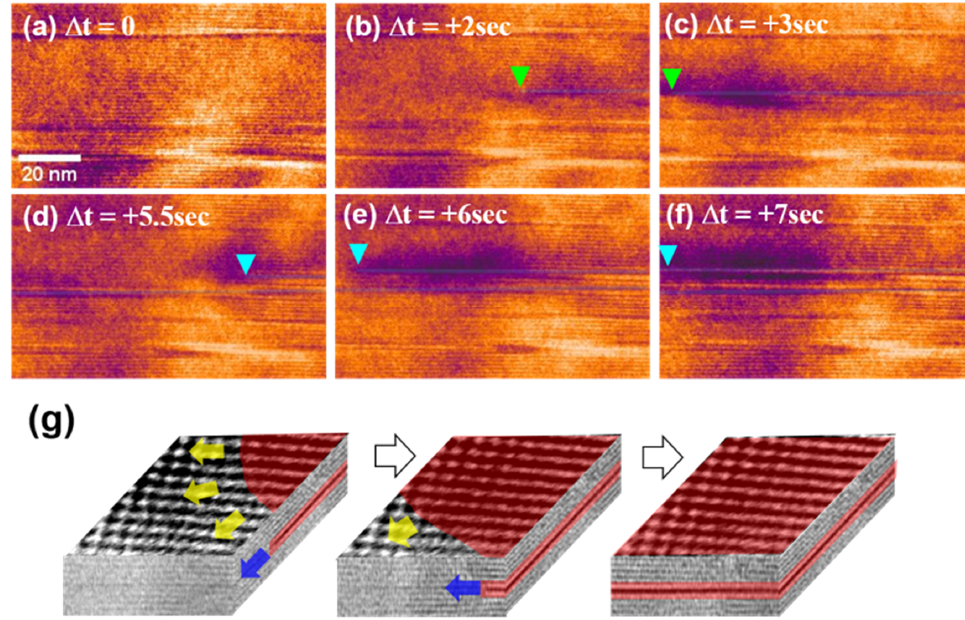
Figure 3. ( a – f ) Sequential BF-TEM images showing the growth of faulted regions caused by Na ion conduction. ( g ) Three-dimensional representation (perspective diagrams) of the spinel block generation. The top view images were extracted from the Movie S2 (viewing direction: [0001]). The front and side view images were taken from the Movie S3 (viewing direction: (cid:7) 112(cid:4)0 (cid:8) ) of the spinel blocks generation.